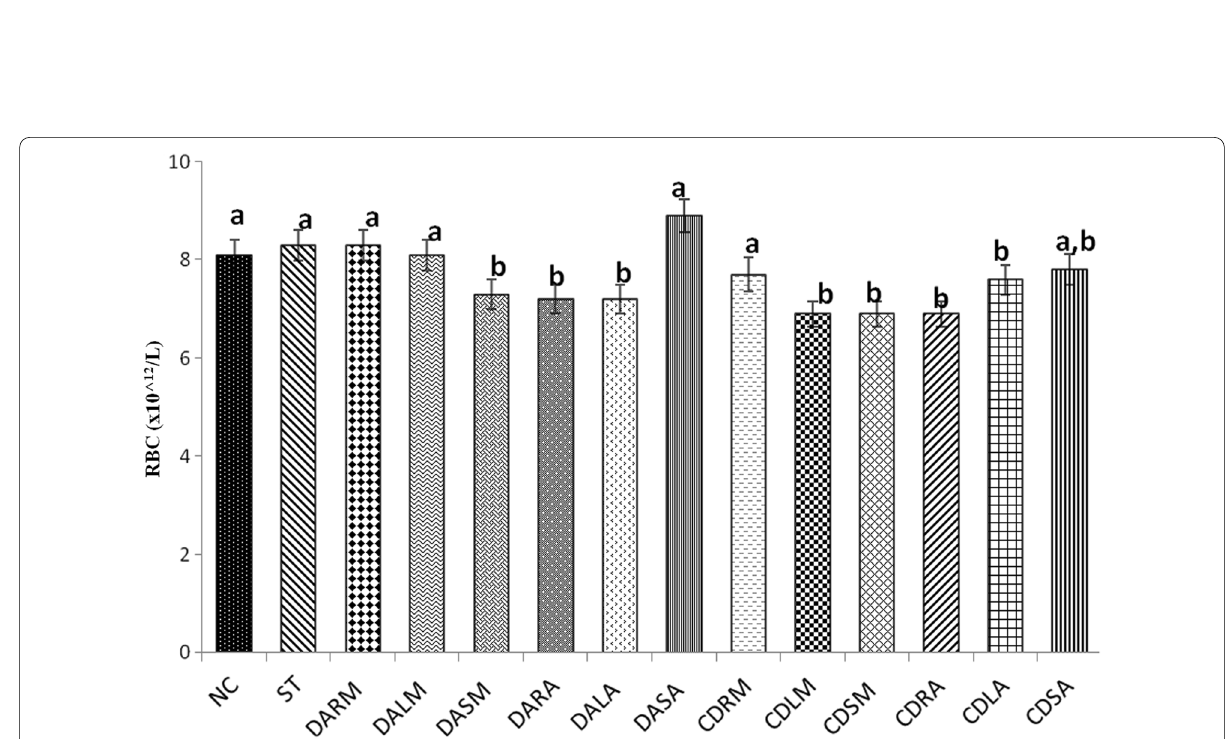
Fig. 2 Effects of methanolic and aqueous extracts of roots, leaves and stem of D. arborescens and C. dependens on Red blood cells (RBCs) of albino rats. Bars with similar alphabets are not statistically different ( p <